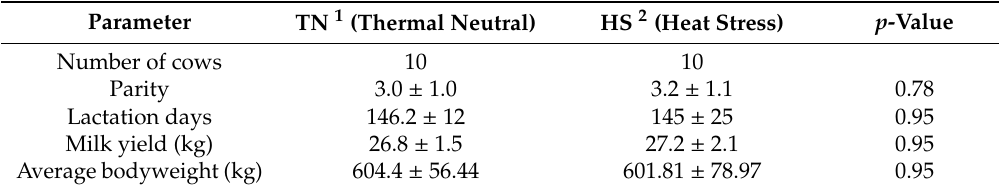
Table 1. Characteristics of the experimental